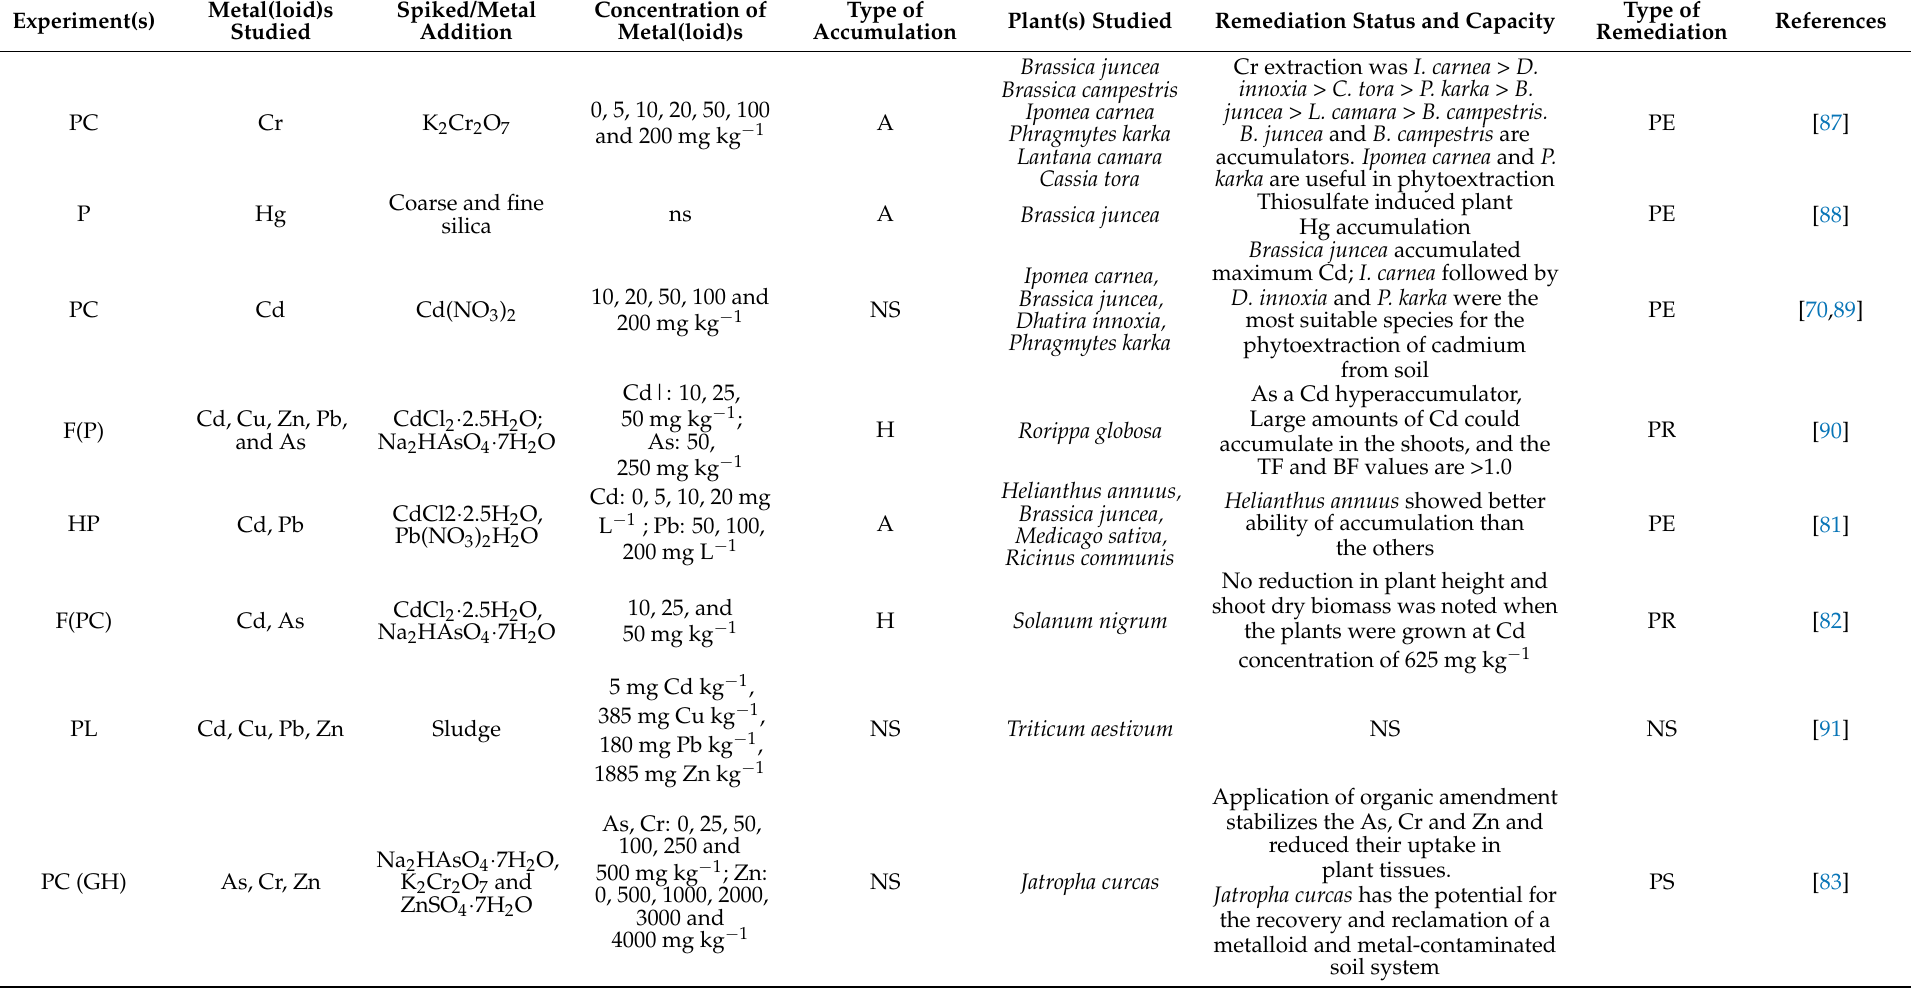
Table 2. List of competent plant species used to study the remediation potential under spiked metal contaminated